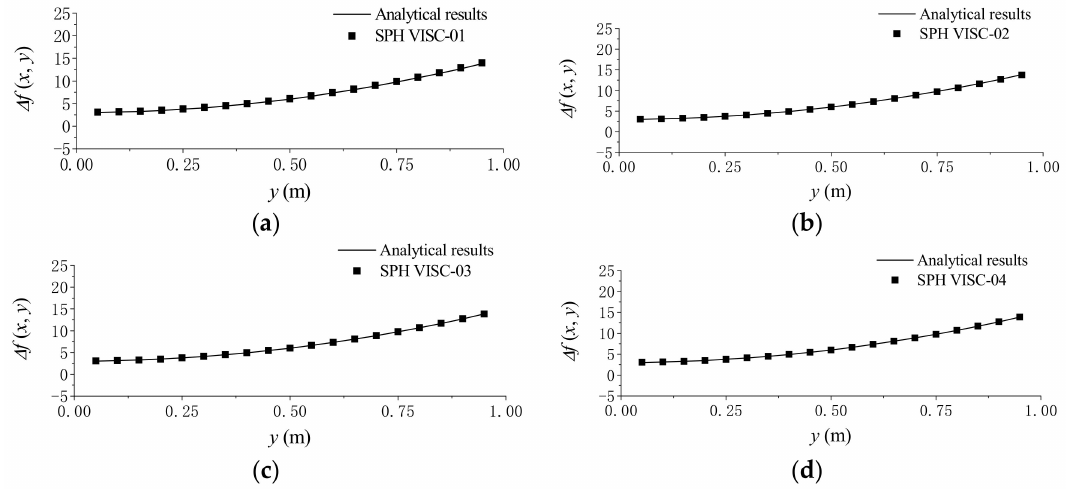
Figure 2. Comparisons of analytical and numerical results computed by using different viscosity force models with the uniform particle distribution: ( a ) VISC-01; ( b ) VISC-02; ( c ) VISC-03; and ( d ) VISC-04. SPH, Smoothed Particle Hydrodynamics; VISC, Viscosity Force Model.